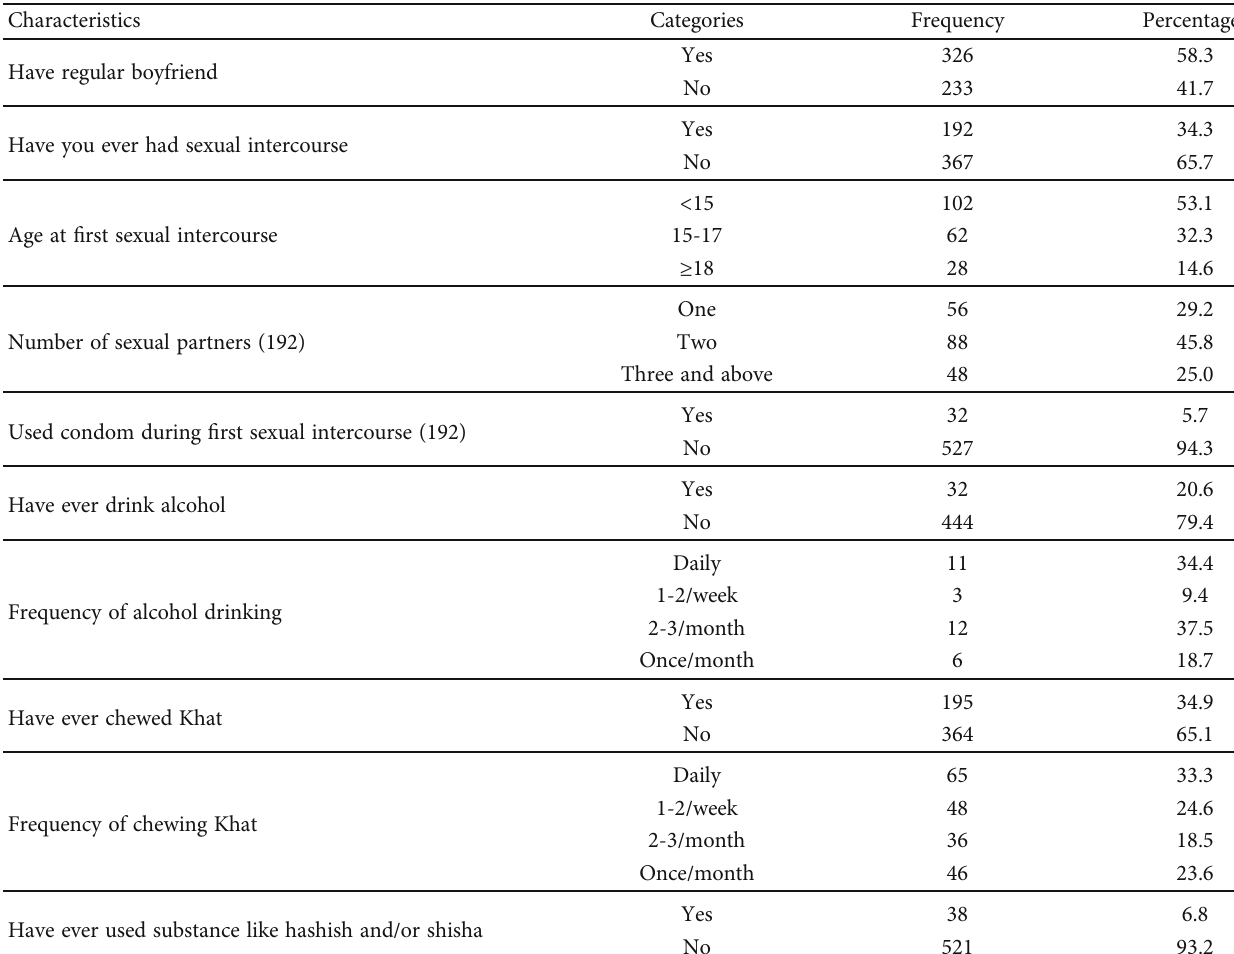
Table 2: Sexual history and substance use condition among high school female students in Jarso district, Oromia region, eastern Ethiopia, 2019 ( n = 559